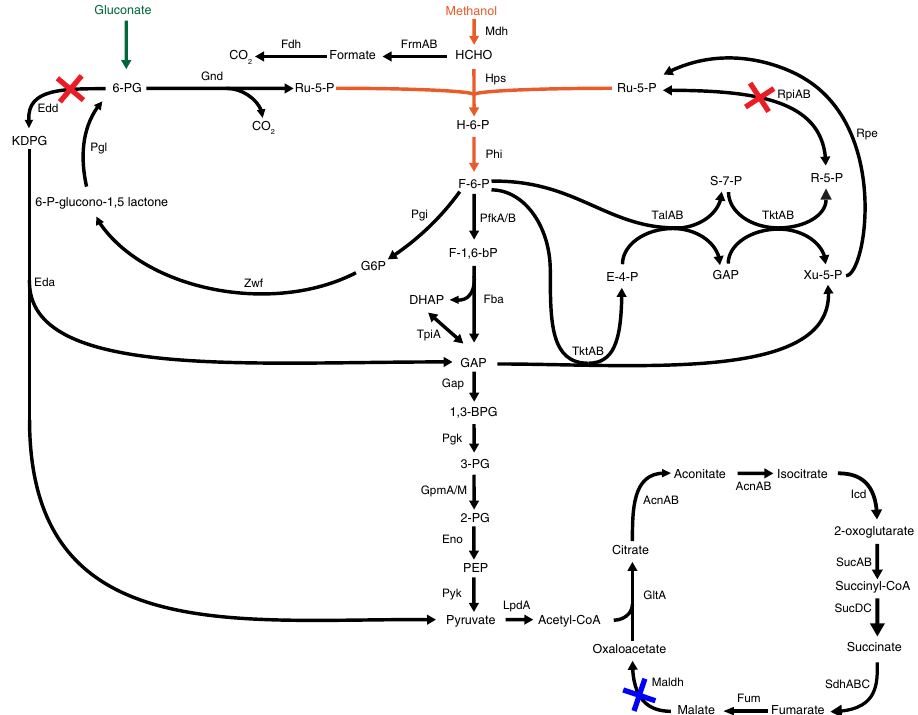
Fig. 2 Metabolism of a methanol-essential Escherichia coli strain. The introduced synthetic pathway is depicted in orange and comprises methanol dehydrogenase (Mdh), 3-hexulose-6-phosphate synthase (Hps), and 6-phospho-3-hexuloisomerase (Phi). Identi fi ed knockouts leading to methanol essentiality in the case of gluconate as a carbon source are shown in red; phosphogluconate dehydratase ( edd ) and ribose-5-phosphate isomerase ( rpiAB ). The knockout for reducing TCA cycle activity and mimicking natural methylotrophs is shown in blue; here malate dehydrogenase ( maldh ). Names and abbreviations are given according to the Biocyc database